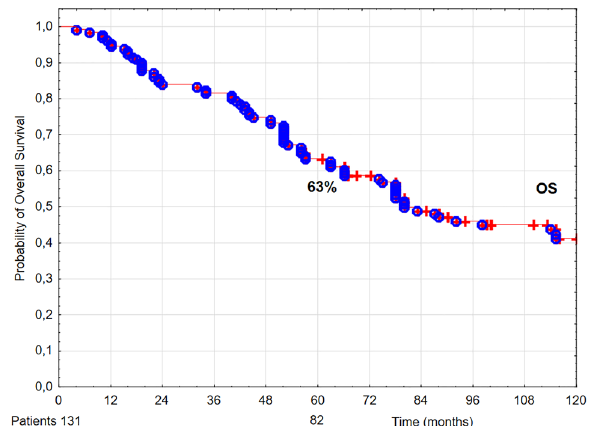
Figure 1. The probability of 5-year overall survival (OS) in T1 glottic cancer patients aged 70 and above.